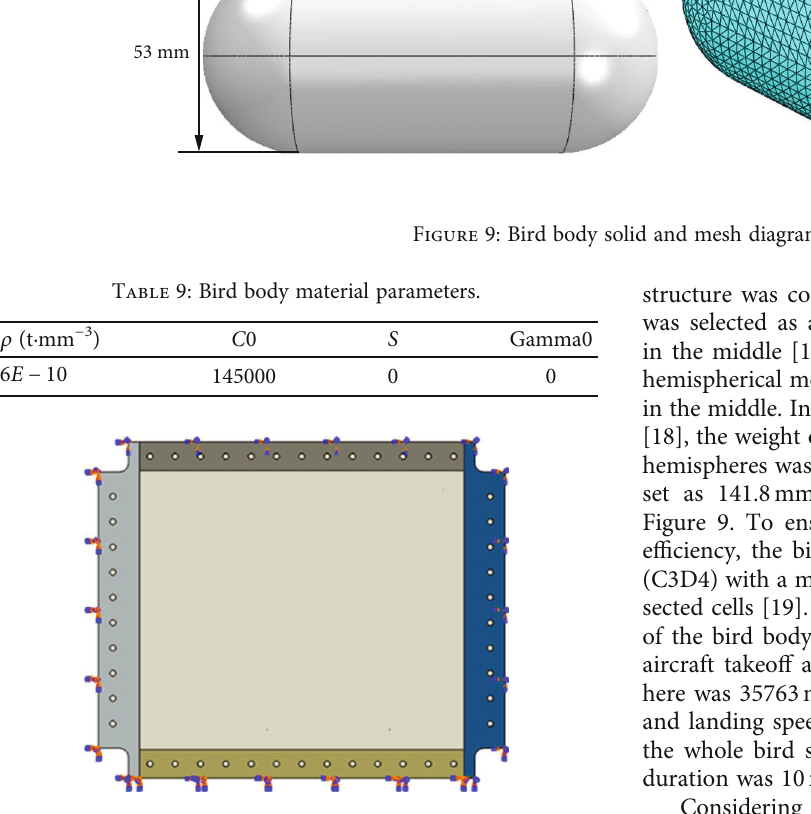
Figure 10: Bird collision boundary conditions.